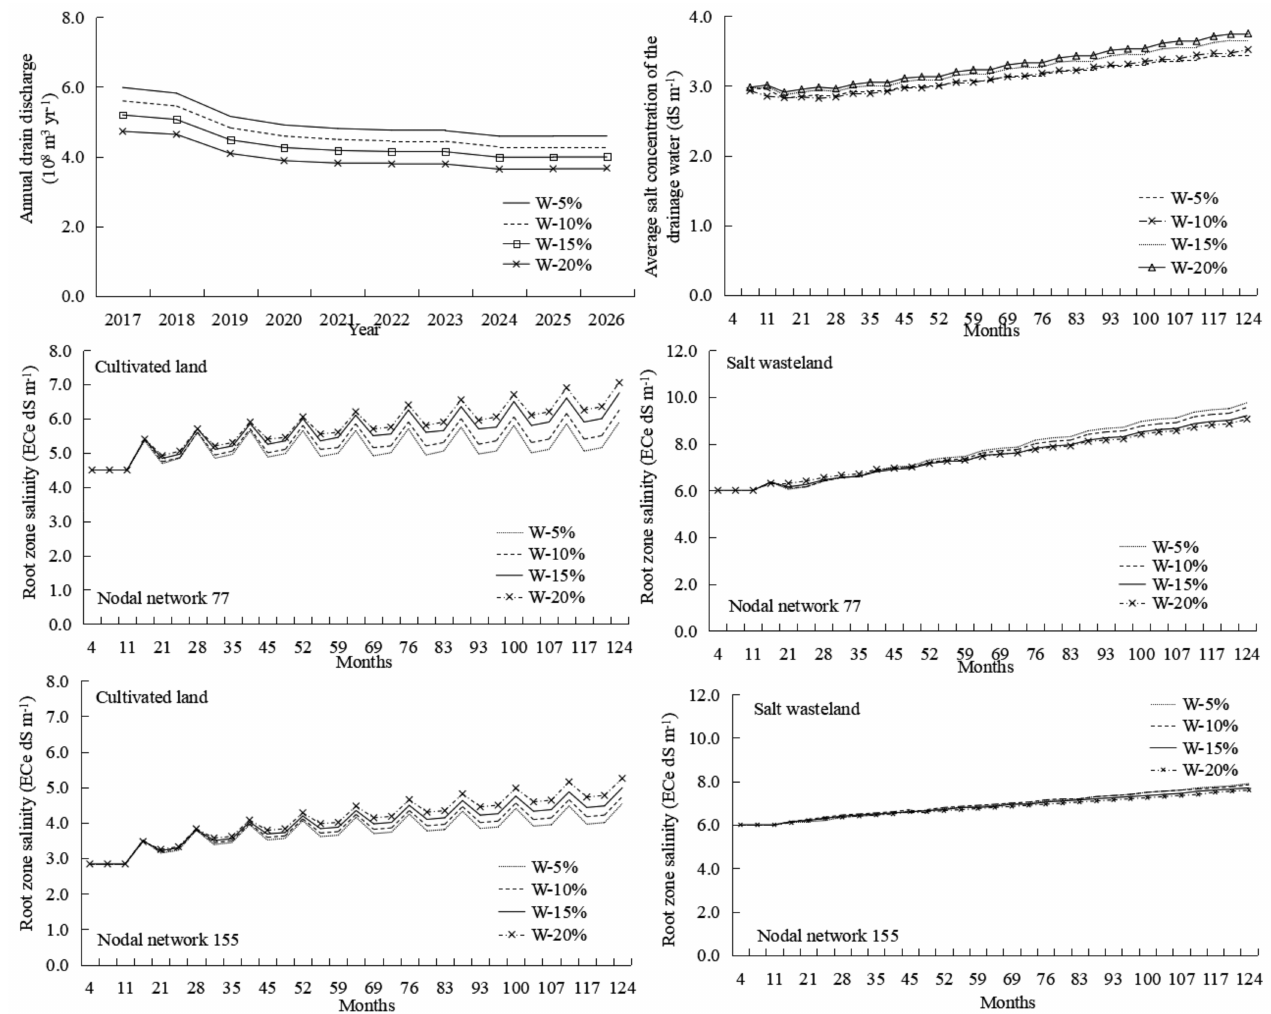
Figure 8. Variation of the annual drain discharge, drainage water salinity, and soil salinity dynamics of the cultivated land and salt wasteland under different water diversion